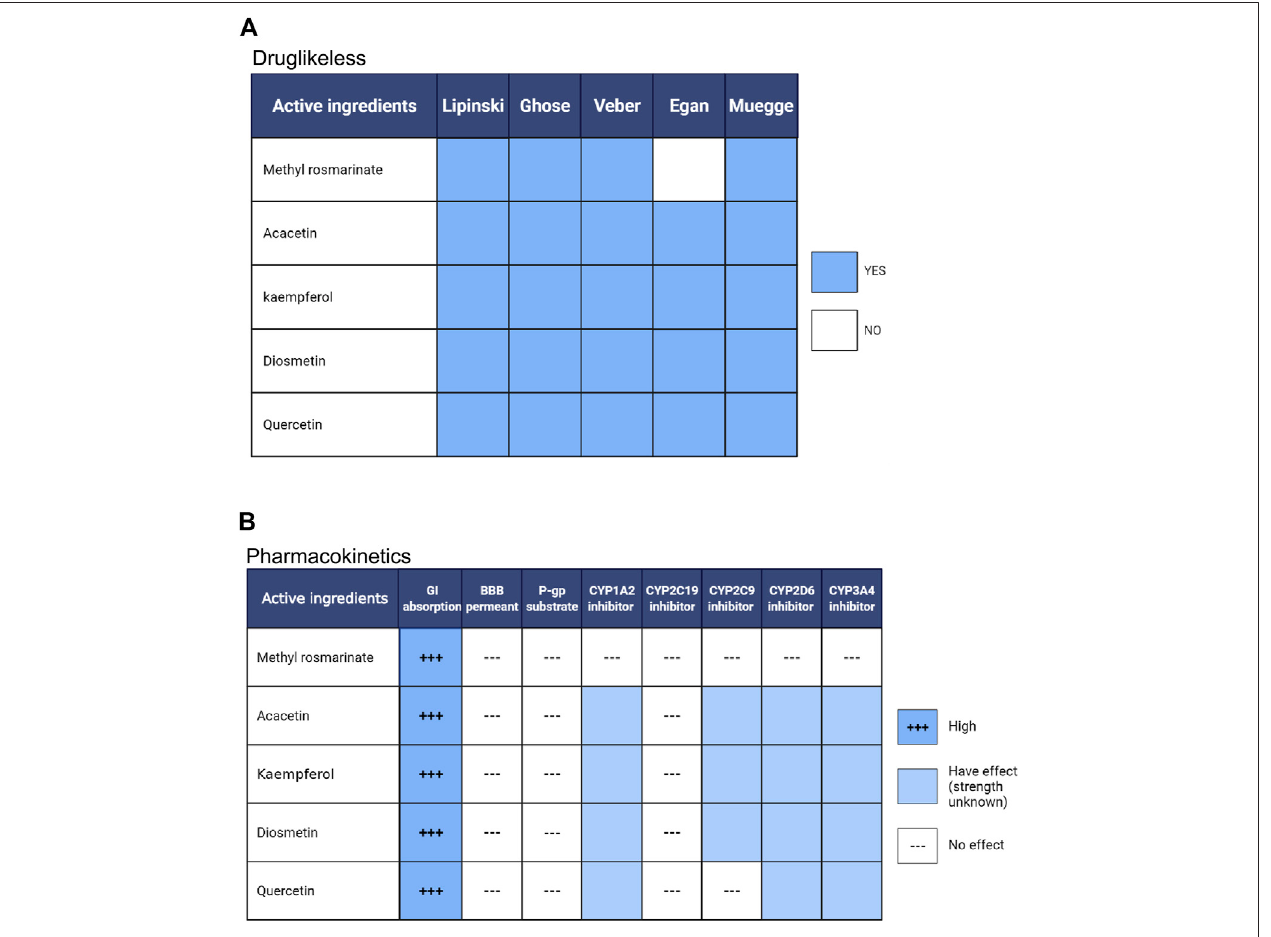
FIGURE 7 | Pharmacokinetic (A) and drug-likeness (B) analysis of compounds. GI absorption, Gastrointestinal absorption; BBB permeant, blood-brain barrier permeant; P-gp substrate, permeability glycoproteins substrate, CYP, cytochrome p450. Created by Biorender(https://biorender.com/).